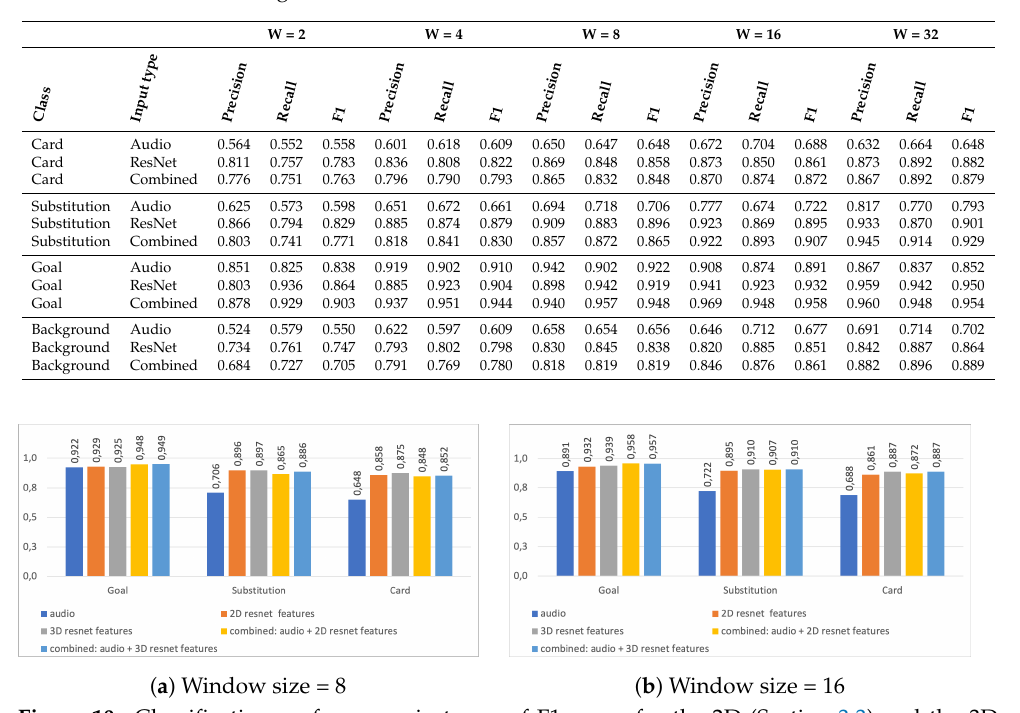
Figure 10. Classification performance in terms of F1 score, for the 2D (Section 3.3) and the 3D (Section 3.2) models using different input types. We present the results for selected samples from Tables 6 and 7, using window sizes of 8 and 16. The results for the combined input types are obtained using softmax average. We observe that for the Goal class, the multimodal approach always performs